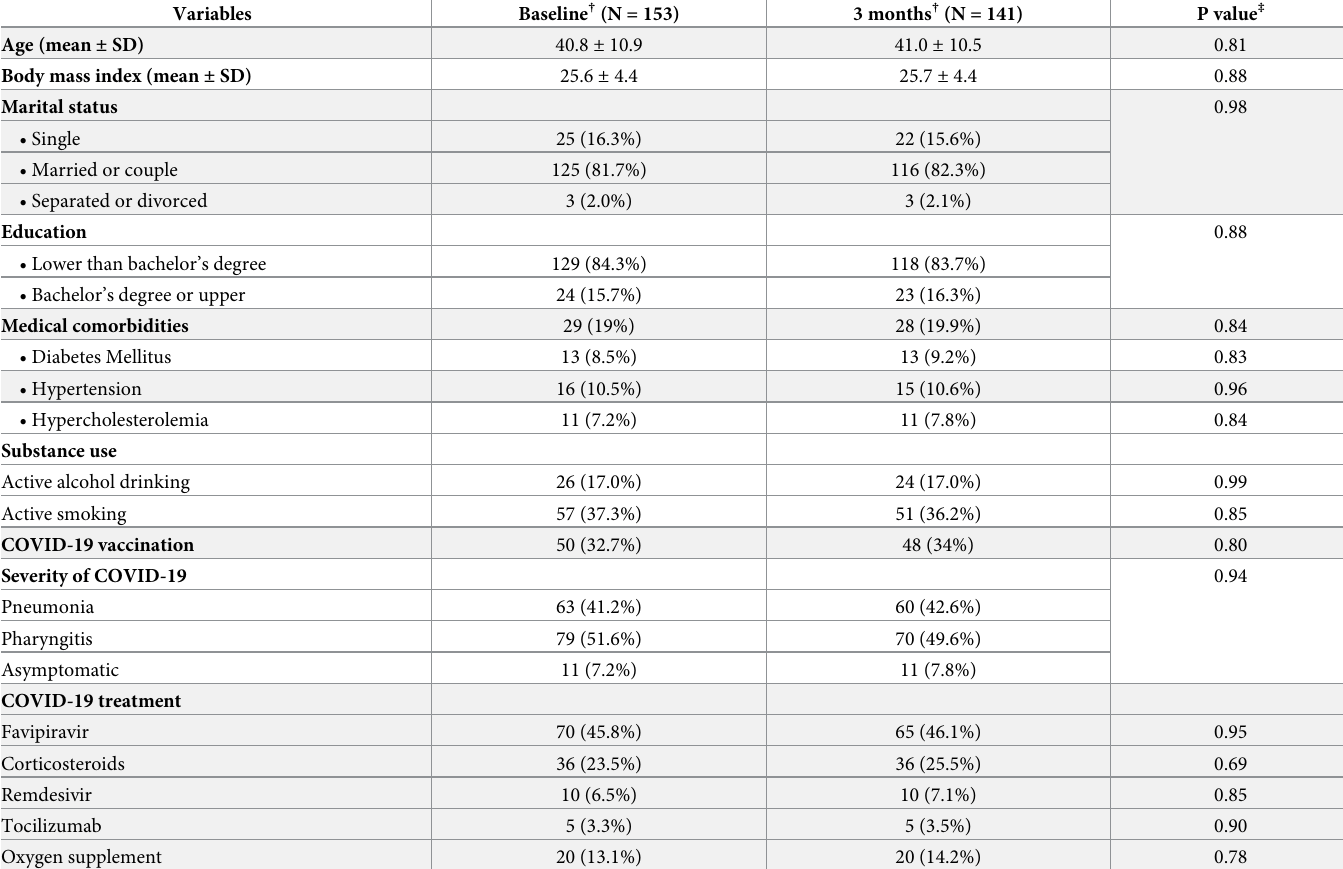
Table 1. Demographic data at baseline and three months after COVID-19